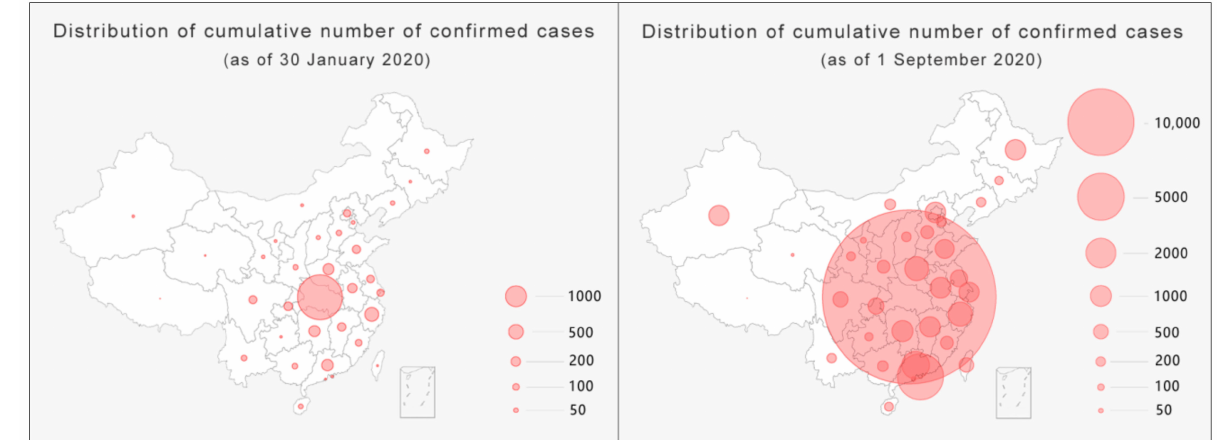
Figure 6. Visualization of a bubble